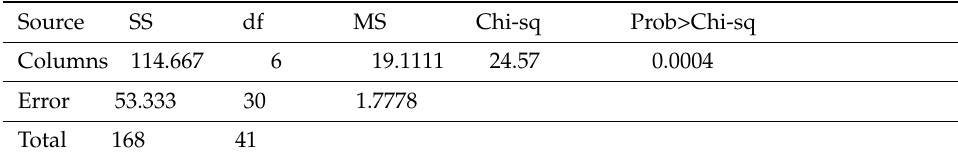
Table 5. Friedman’s ANOVA table.